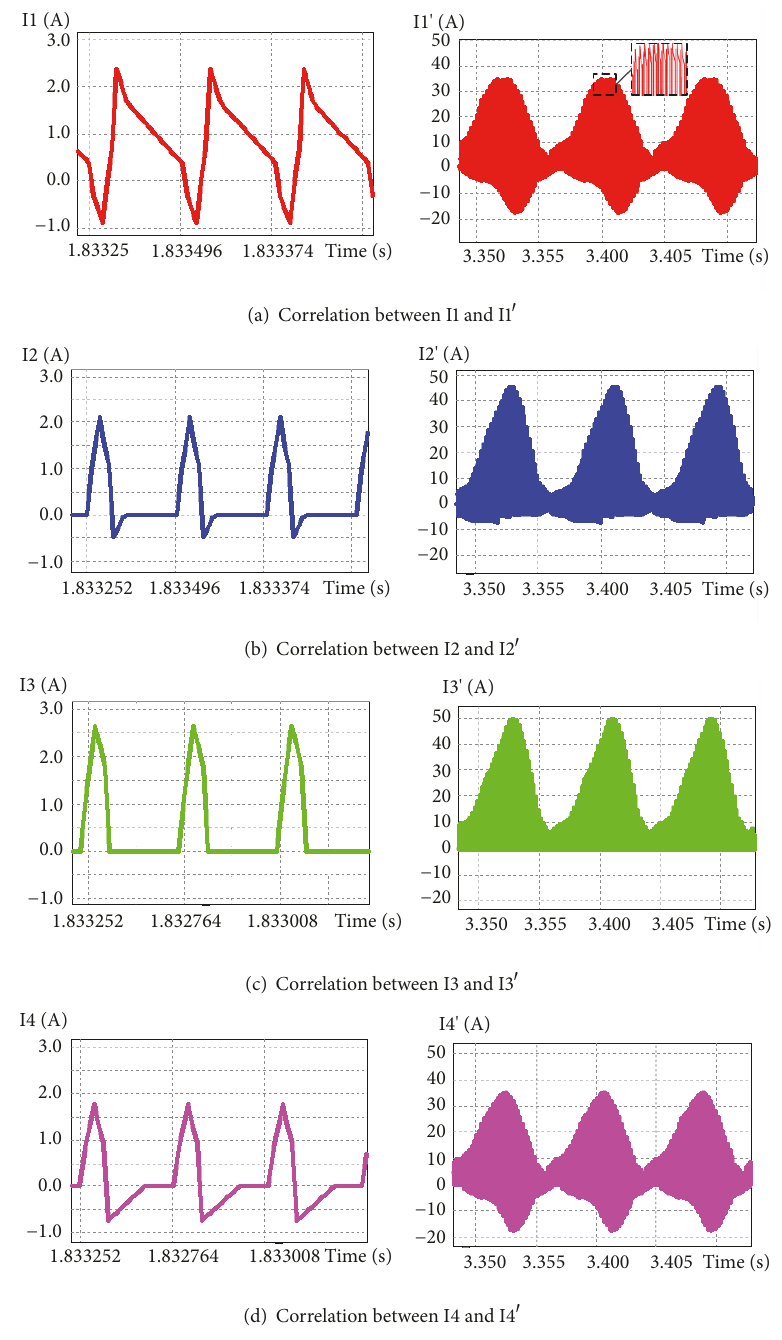
Figure 13: Correlation between current waveforms for two driven